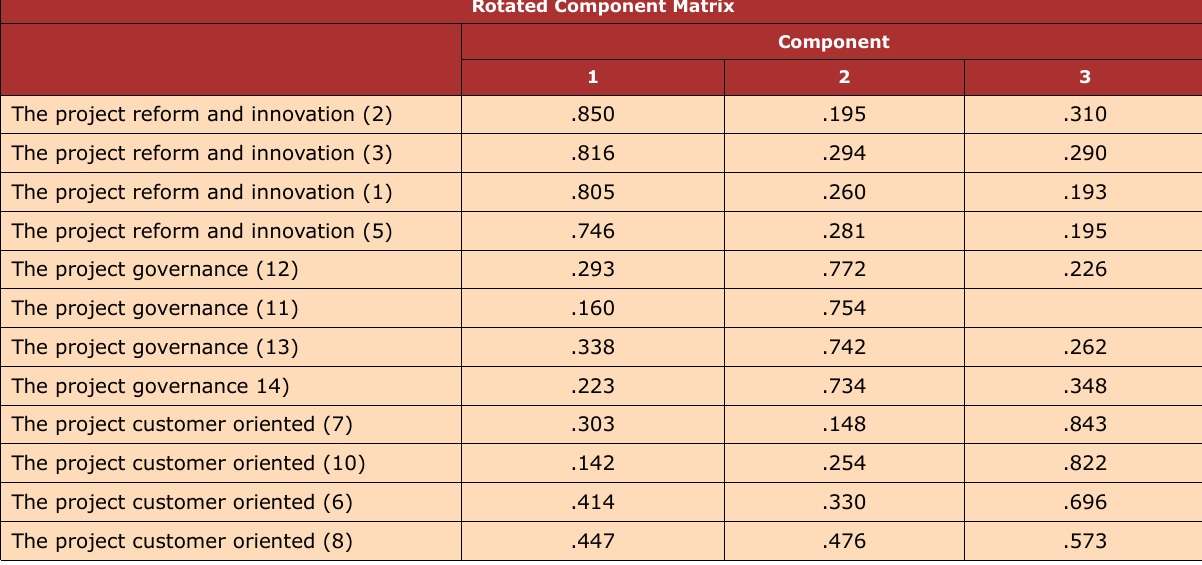
Table 7. Factor analysis of adaptability